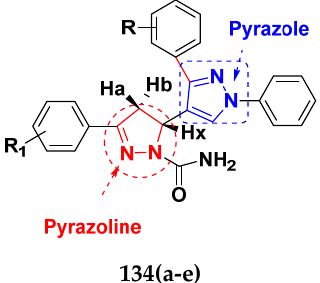
Figure 123. Structure of pyrazoline ‐ pyrazole ‐ based derivatives 134 ( a – e ). Table 110. In vitro cytotoxic activities of pyrazoline ‐ pyrazole ‐ based hybrid compounds 134 ( a – e ). Compound